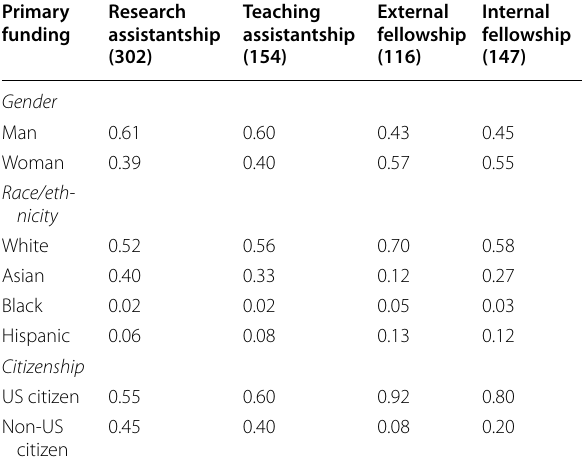
Crosstabs table of gender, race/ethnicity, and